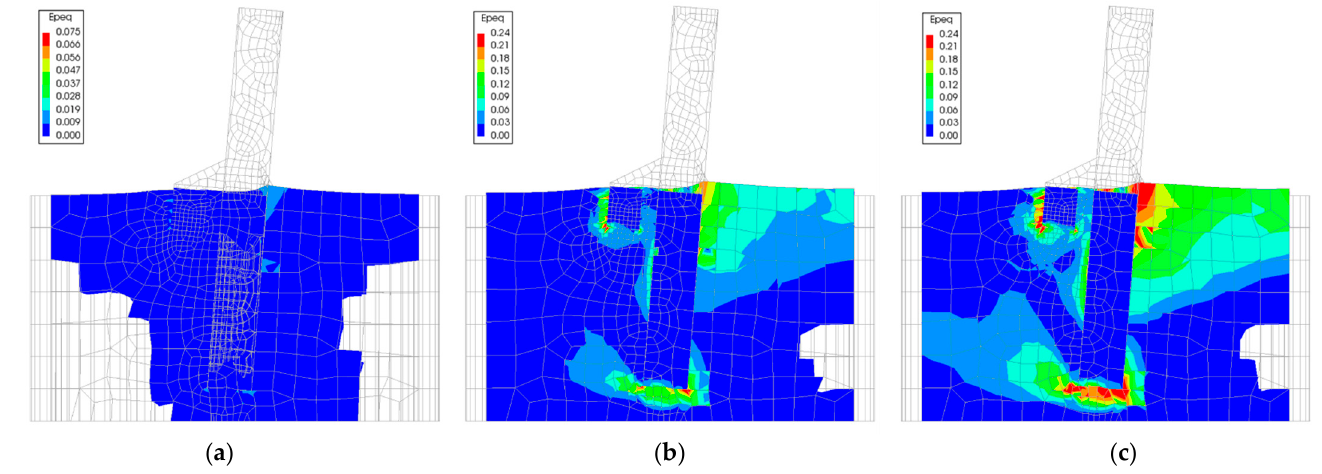
Figure 10. Failure of hybrid monopile foundation: ( a ) initial loading ( δ = 5 mm); ( b ) peak load ( δ = 45 mm); ( c ) residual state ( δ = 80 mm); where δ : lateral displacement at the top of the monopile, Epeq: equivalent plastic strain (mm/mm).